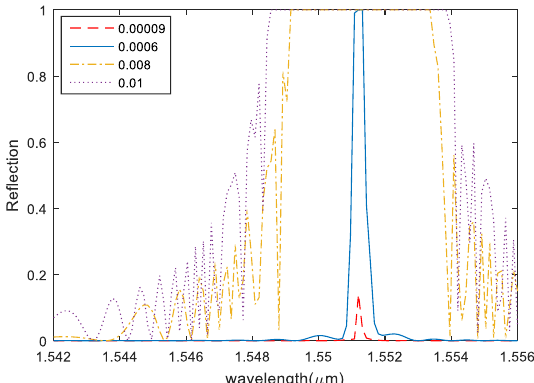
Figure 7: Reflection response in FBG with different index modulation under 1000 micro strain.